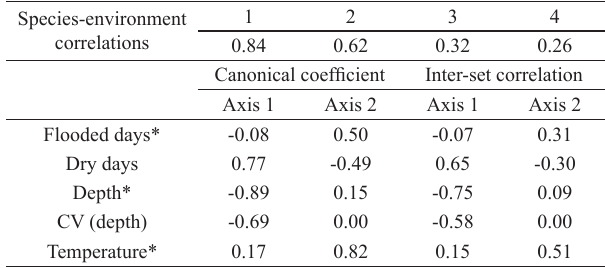
Tab. 2. Summary of redundancy analysis. Asterisks denotes significant variables (p < 0.05) in de RDA model based on 1000